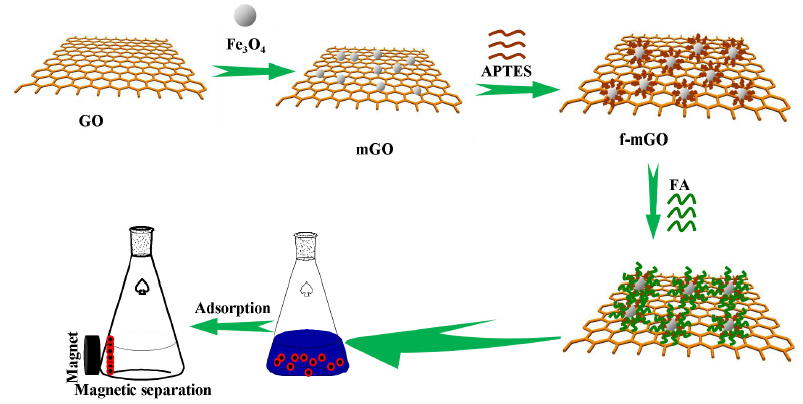
Figure 14. Synthesis, adsorption, and separation process of f-mGO (Reproduced or adapted from ref. [134], with permission from Elsevier, ref. [135] , with permission from Elsevier, 2020).